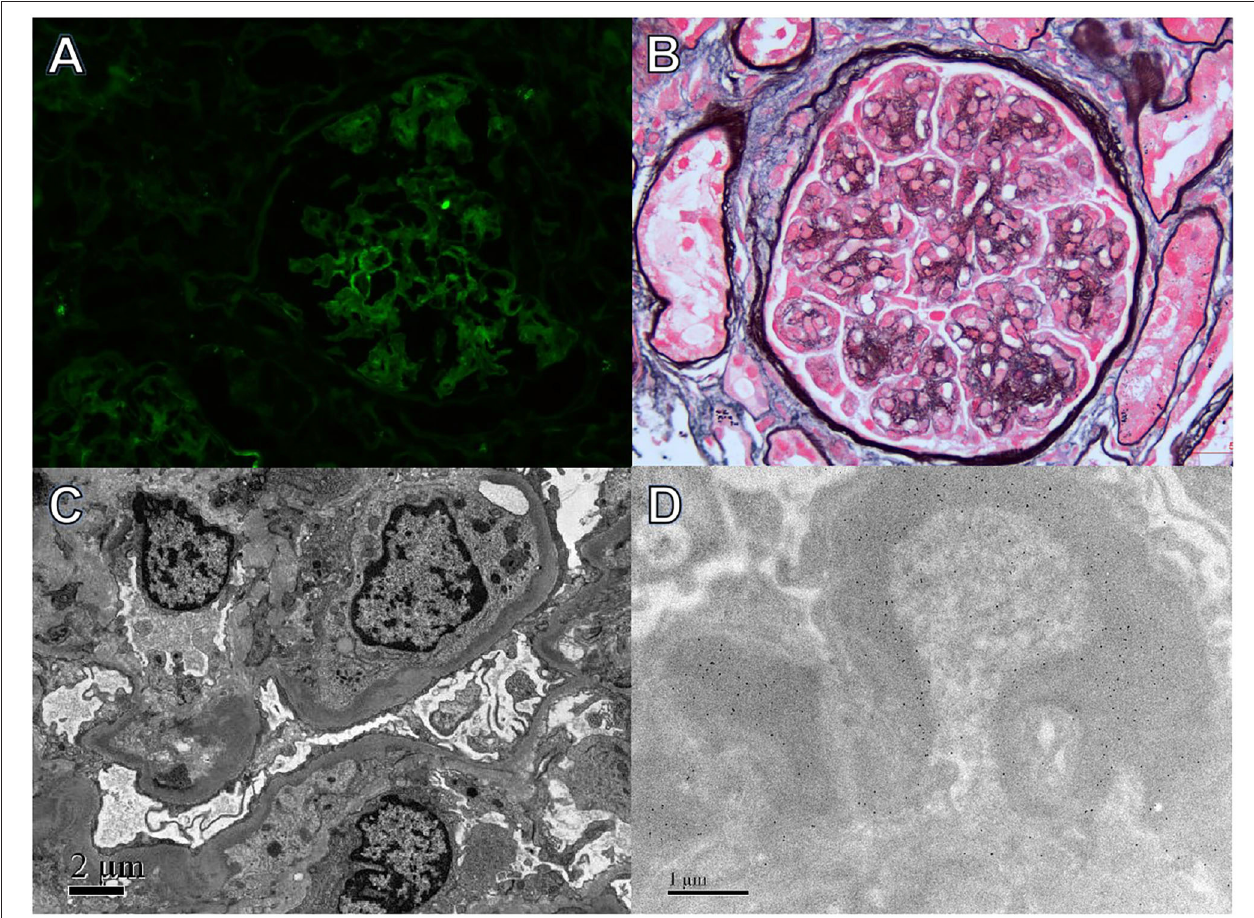
FIGURE 1 | Light, immunofluorescence, electron, and immune-electron microscopy findings in Case 1. (A) Immunofluorescence studies revealed bright λ staining in the segmental mesangial area and along capillary walls ( × 400). (B) Light microscopy showed a mesangial proliferative pattern of injury (periodic acid-silver methenamine + Masson trichrome staining, × 400). (C) Electron microscopy revealed electron-dense deposits in segmental mesangial and subendothelial regions ( × 800). (D) Immunoelectron microscopy demonstrated λ deposition in the mesangial area and segmental subendothelial regions ( ×